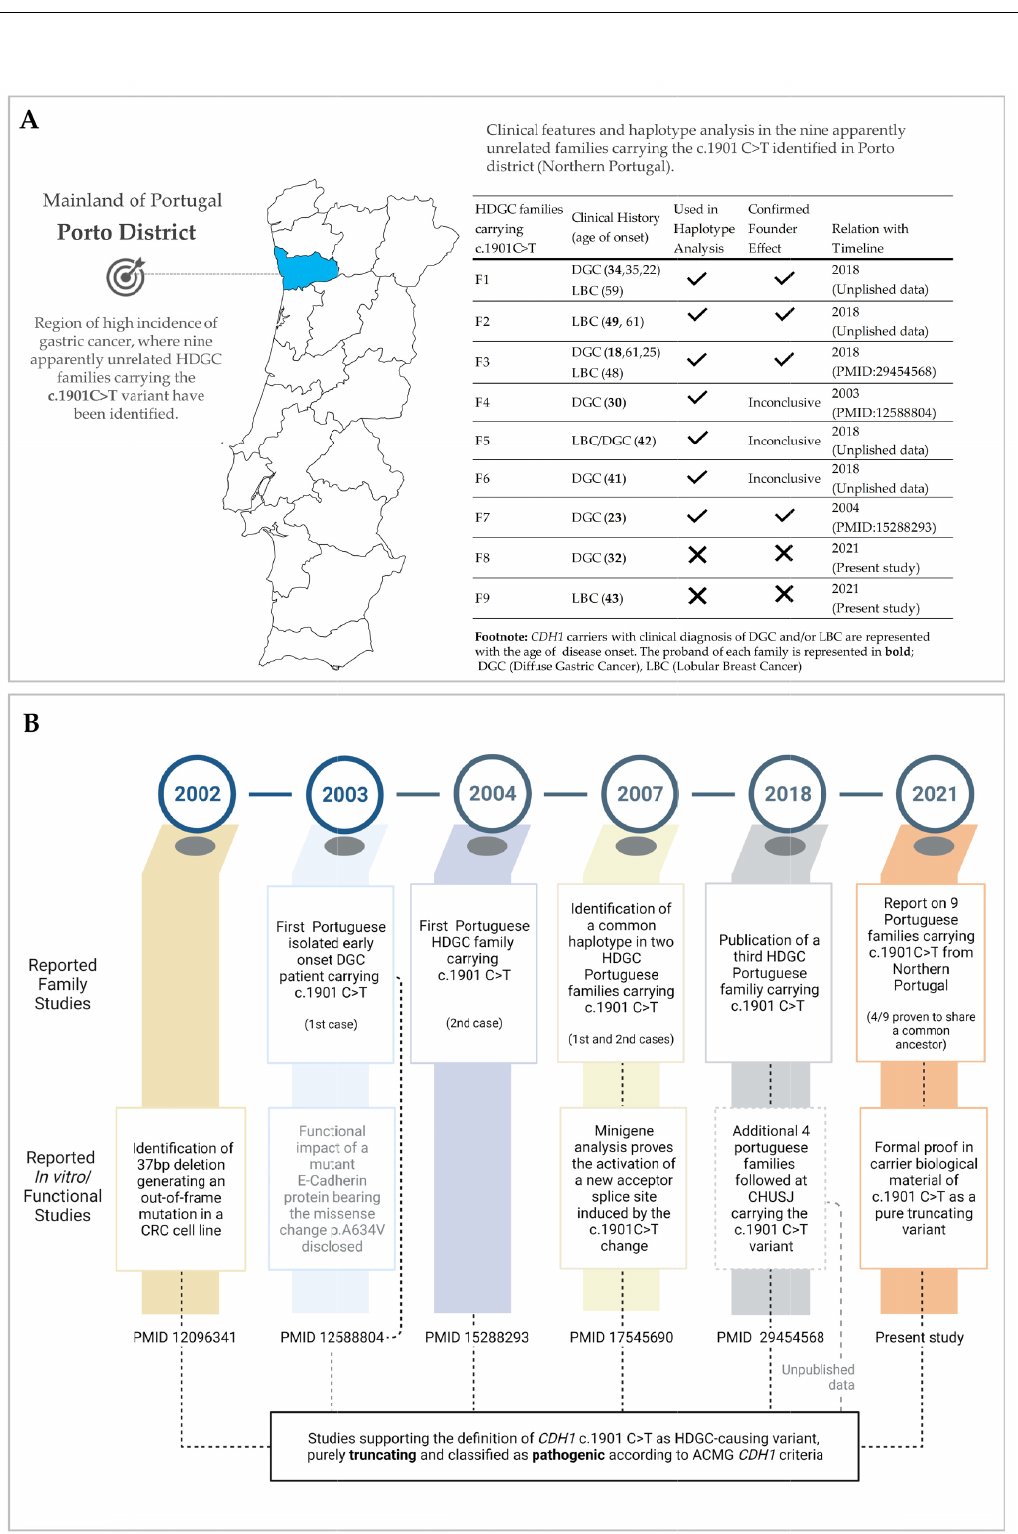
Figure 1. Timeline of the discovery of a CDH1 -related founder effect in Northern Portugal: the CDH1 c.1901C>T variant. ( A ) Map of the mainland of Portugal highlighting the Porto district in Northern Portugal, a region of high incidence of GC where the nine c.1901C>T variant carriers’ families were identified; and clinical features of carrier families (right hand side table). ( B ) Timeline of discoveries related to the c.1901C>T CDH1 variant: from pathogenicity to carrier families. CRC, colorectal carcinoma; DGC, diffuse gastric cancer; HDGC, hereditary diffuse gastric cancer; CHUSJ, Centro